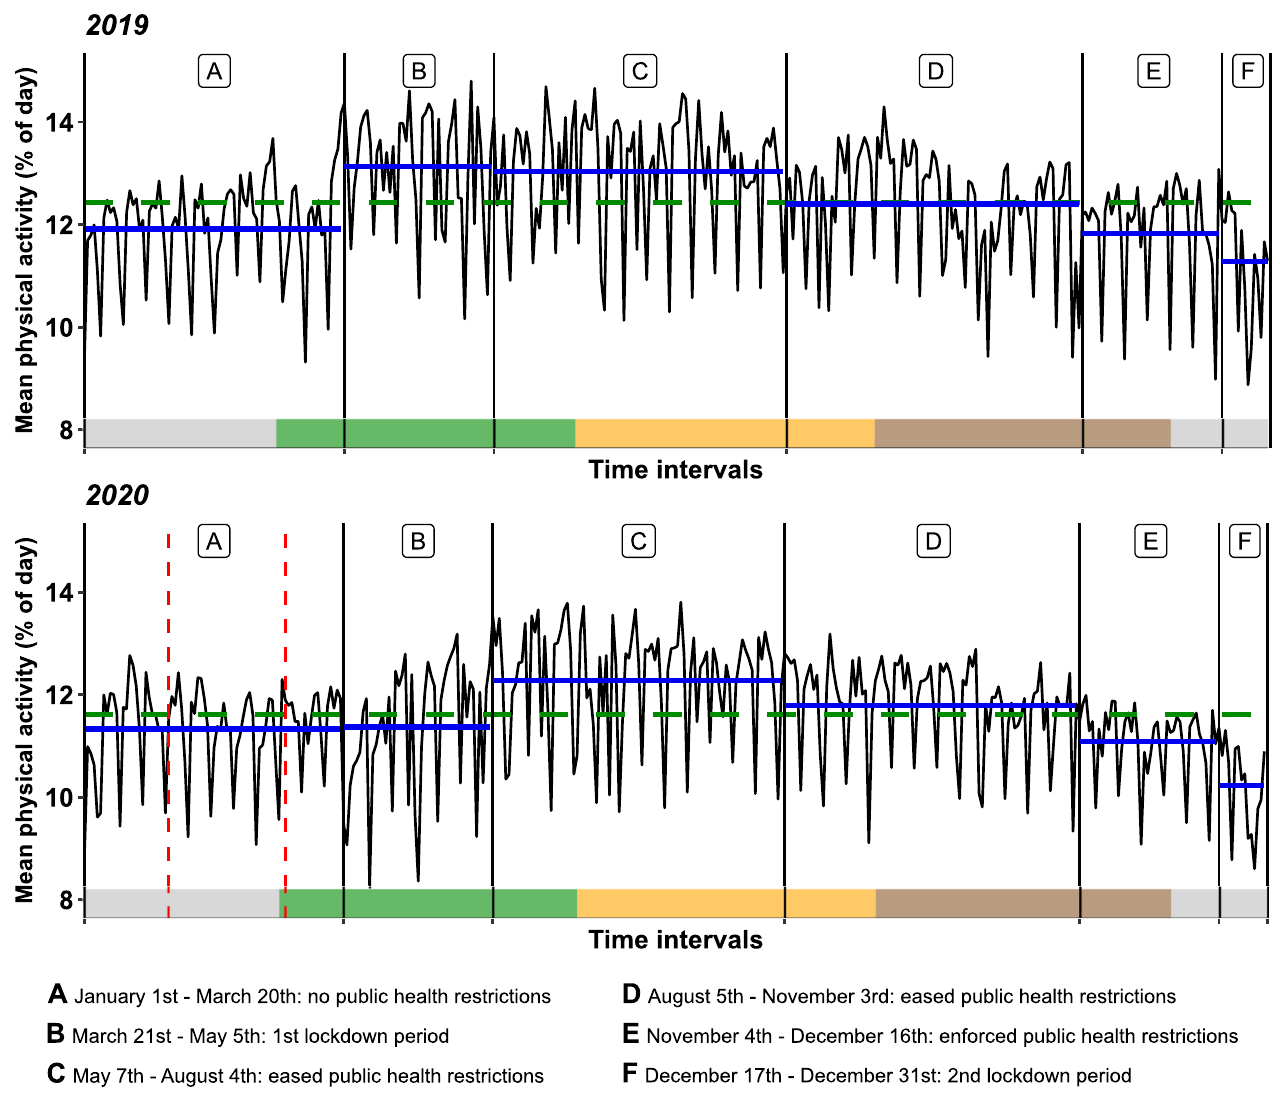
Fig 1. Longitudinal analysis of device derived physical activity in the years 2019 and 2020. Intervals A to F, graphically separated by vertical black lines, indicate time intervals characterized by different levels of public health restrictions in the year 2020 that were then applied analogously to the year 2019. The timepoints of the first case of SARS-CoV-2 confirmed in Germany and of the first case of SARS-CoV-2 confirmed in the city of Wu¨rzburg are annotated by vertical red lines. Arithmetic means of device derived physical activity of the years 2019 resp. 2020 are plotted as green dotted horizontal lines. Median of patients’ physical activity within each time interval A-F are displayed as blue horizontal lines. Time periods of the different seasons are displayed graphically as coloured squares (winter: grey, spring: green, summer: yellow, autumn: brown).